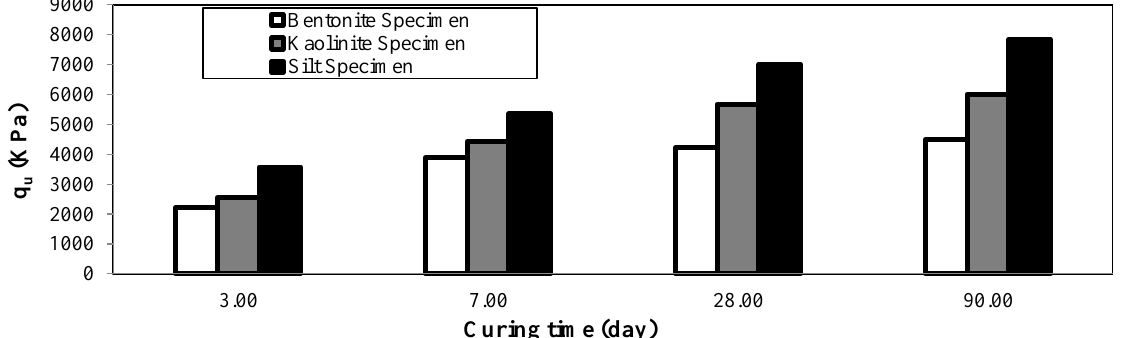
Fig. 9. The uniaxial compressive strength of soil-cement mixtures with different types of fines